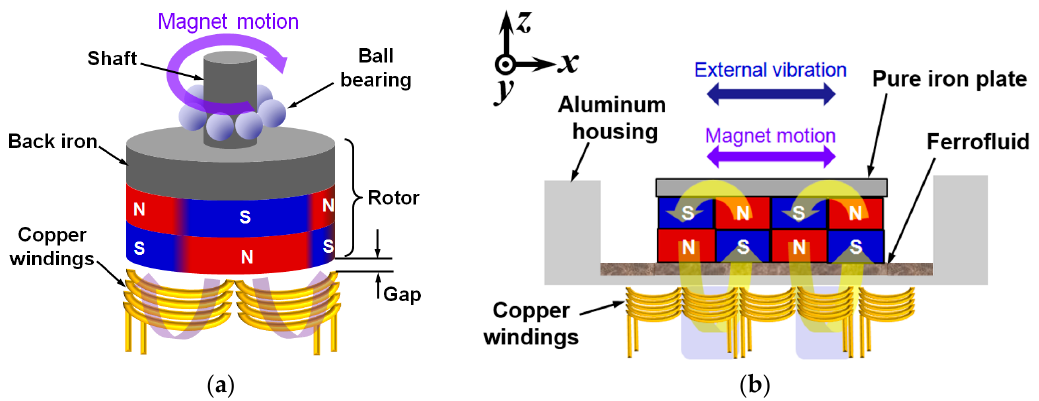
Figure 1. Comparison of electromagnetic power generator structures: ( a ) axial-flux rotary power generator; ( b ) linear vibration energy harvester.